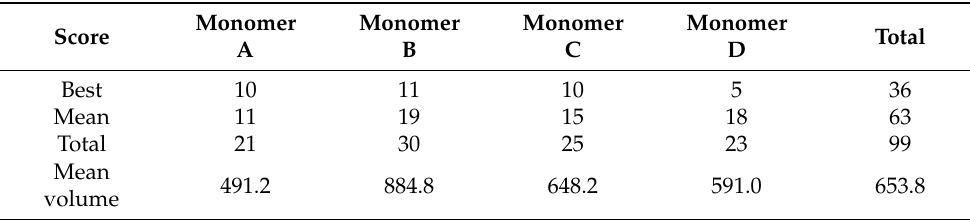
Table 4. Frequency of the scores from the four simulated optimized monomers in the selected consensus equations. The table also includes the mean volumes of the four binding sites in the 50 selected frames (in Å 3